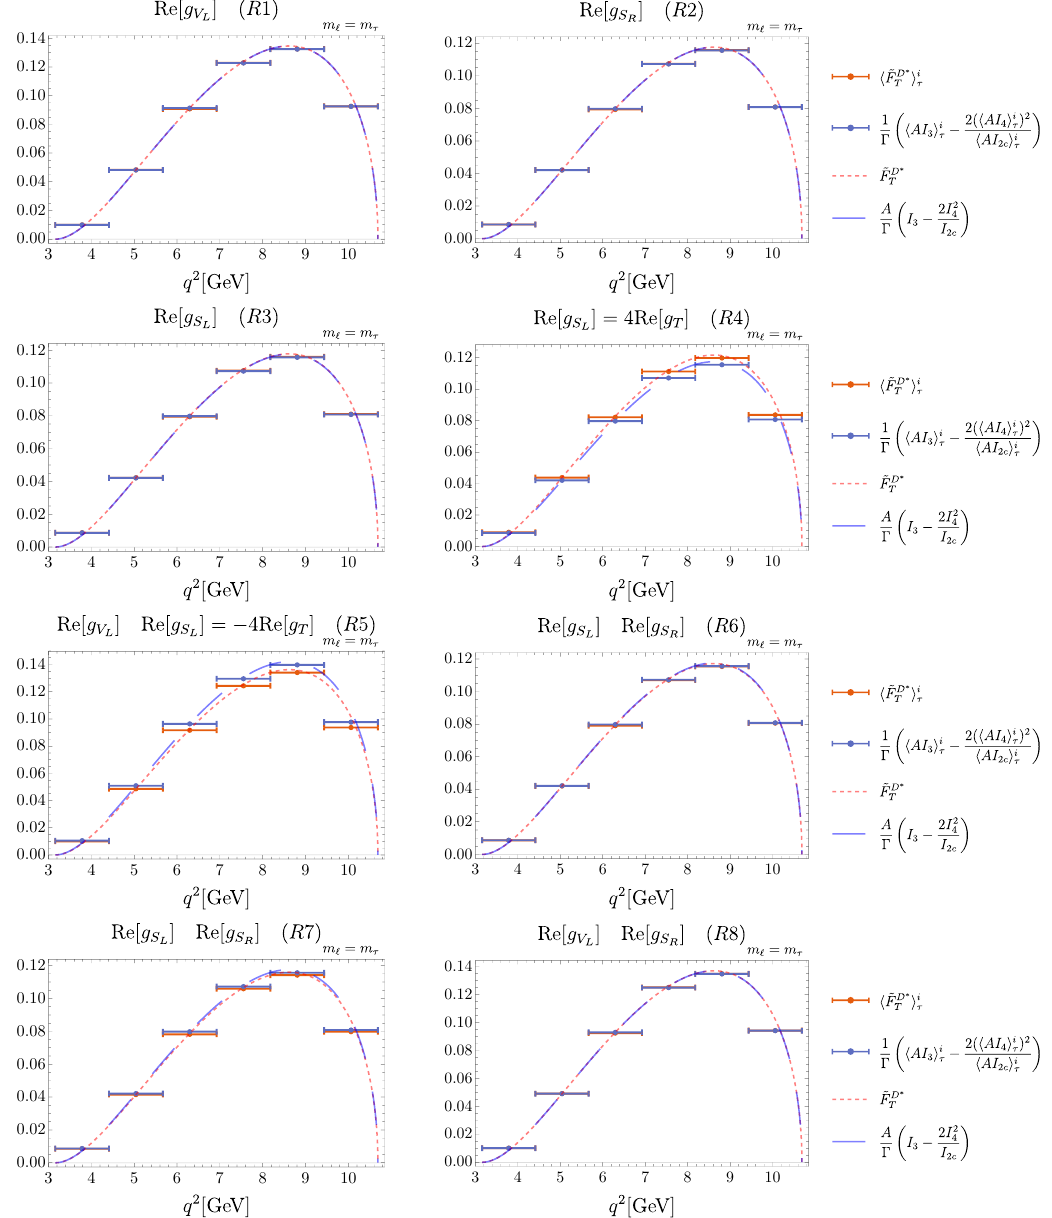
Figure 6. Study of binning e(cid:11)ects for eq. (4.19) for benchmark NP scenarios with real contribu- tions.